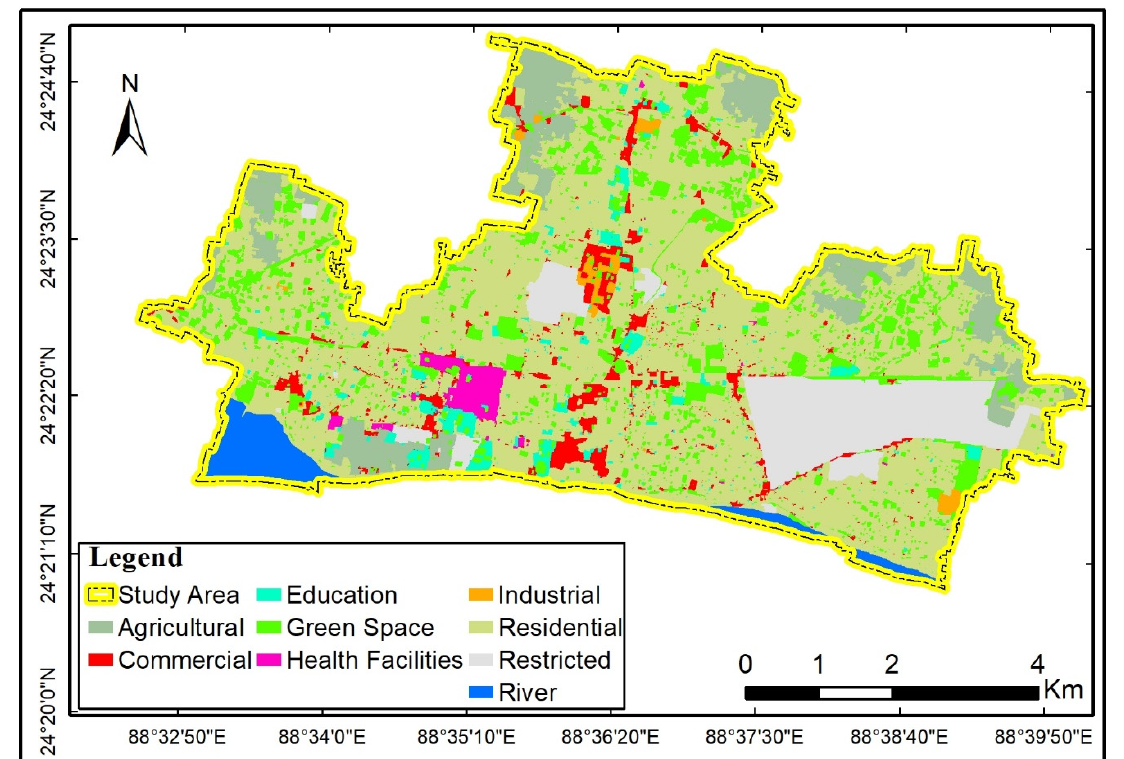
Figure 2. Hypothetical land use ( left ) and population ( right ) data used in this study.